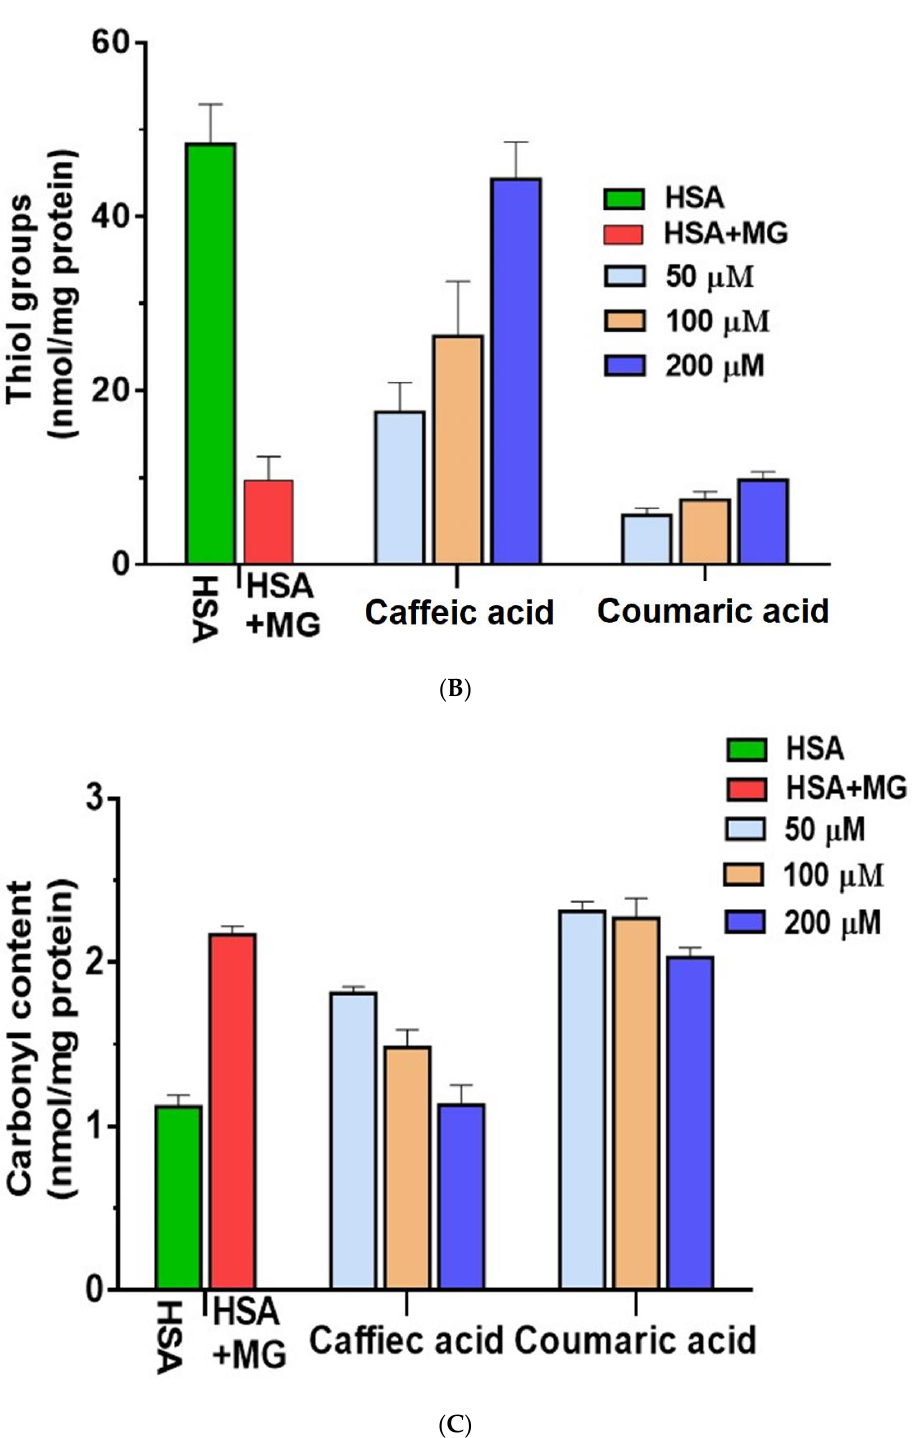
Figure 5. Estimation of antiglycation activity of caffeic and p-coumaric acid by monitoring ( A ) fructosamine content and protein oxidation by measuring ( B ) free thiol groups and ( C ) carbonyl